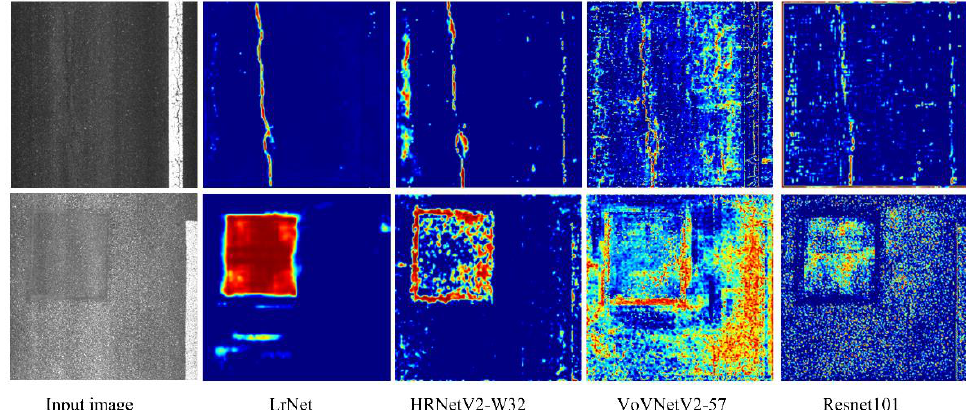
Figure 7. Visualizations of second-stage feature maps of four backbone networks. Red and bright areas denote strong response, blue indicates areas of no concern.